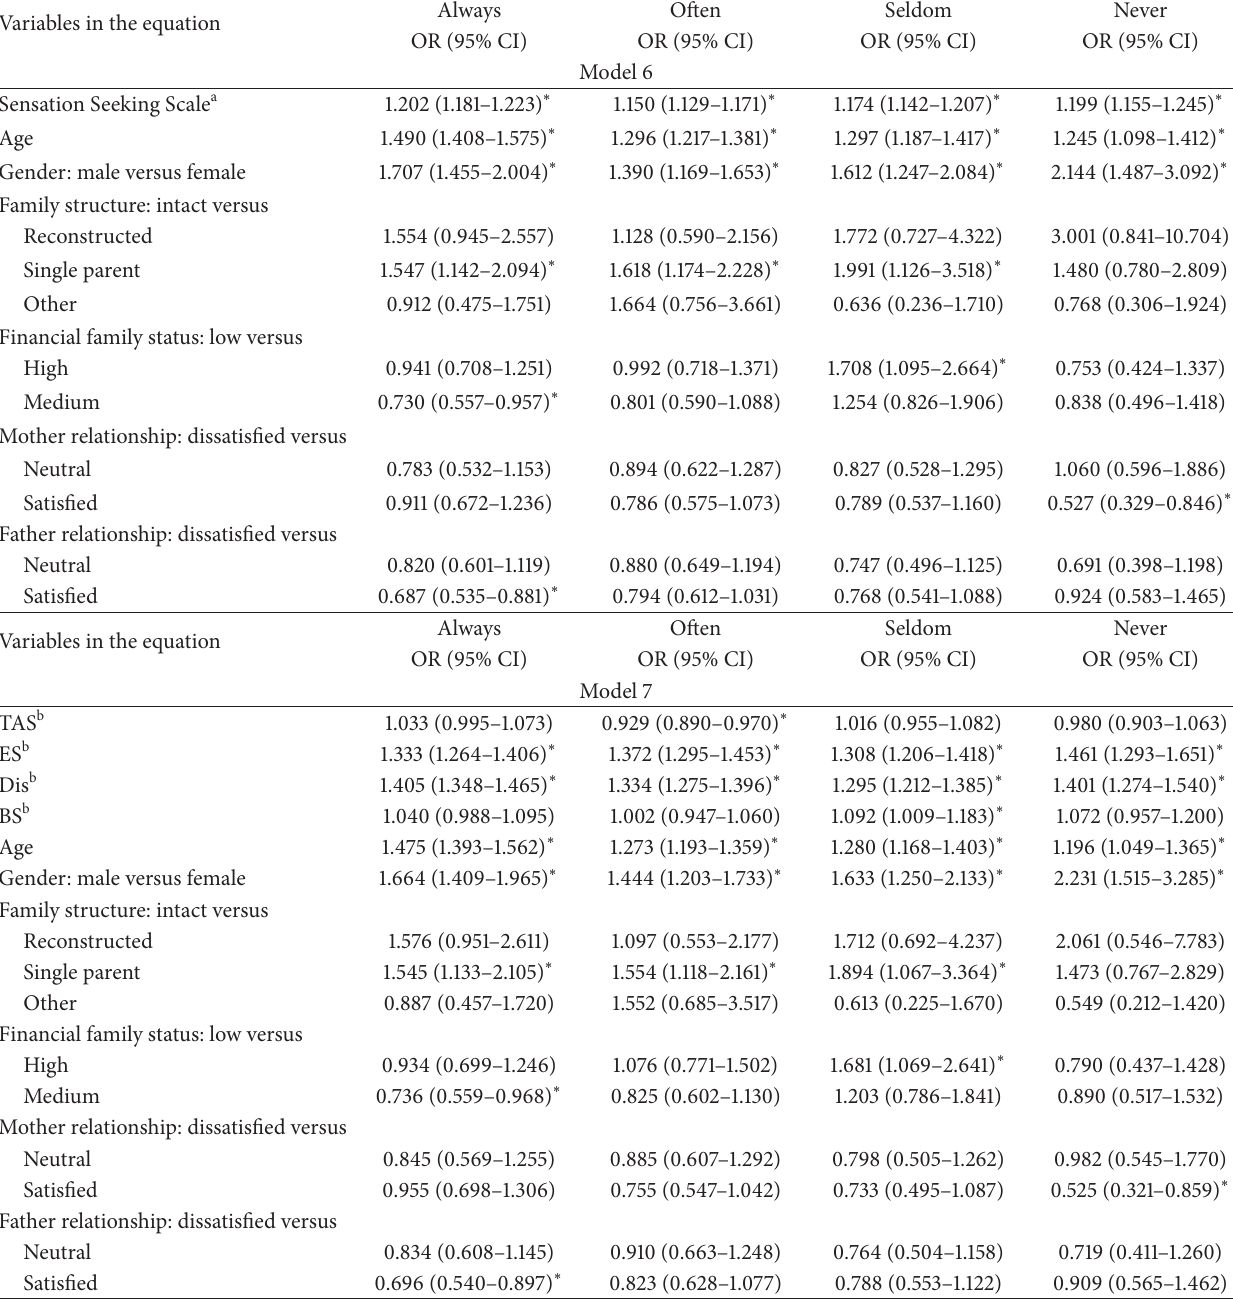
Table 6: Multivariate logistic model for substance use for parental